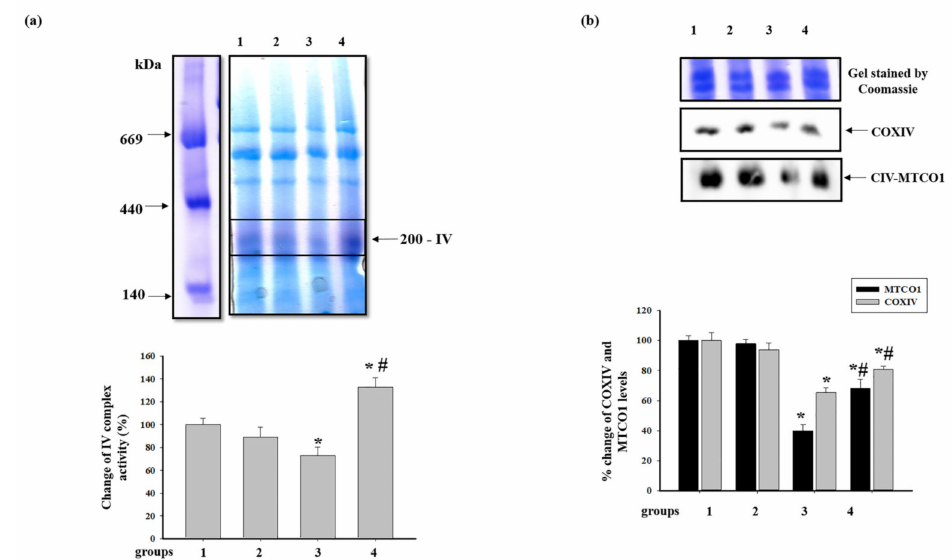
Figure 6. E ff ect of AST and ISO on the activity of complex IV (CIV) in rat heart mitochondria. ( a ) The upper part: freshly prepared rat mitochondria isolated from each group were solubilized in a bu ff er for BNE samples (Materials and Methods Section). Mitochondrial samples were separated by 1D BNE, and the gel was stained for the detection of the activity of CIV by a bu ff er containing 10 mM KH2PO4 (pH 7.4), 1 mg / mL DAB (3,3 (cid:48) -Diaminobenzidine), and 0.2 mg of cytochrome c for 1 h; the lower part: a diagram quantitatively reflecting changes in the activity of CIV; (b) the upper part: the excised bands with enzymatic activity were subjected to 2D SDS-PAGE and blotted onto nitrocellulose for immunodetection using the monoclonal antibodies against COXIV and MTCO1; the lower part: a diagram quantitatively reflecting changes in the protein levels. The data are presented as the means ± SDs of four independent experiments. * p < 0.05—significant di ff erence in the protein level compared with the control (group 1), # p < 0.05 compared to RHM from ISO-injected rats (group 3). The statistical significance of the di ff erences between the pairs of mean values was evaluated using the Student-Newman-Keul test (Supplementary Materials, p.